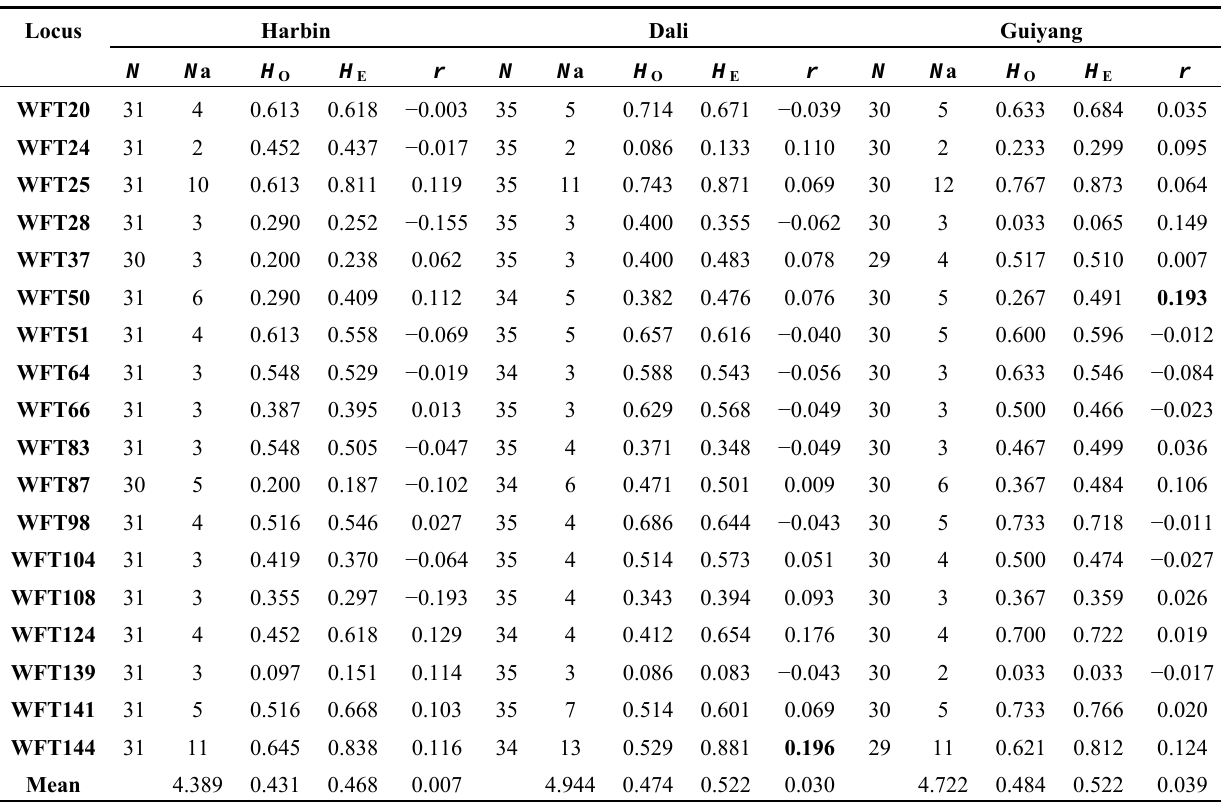
Table 4. Population genetic parameters at 18 microsatellite loci in 3 Frankliniella occidentalis